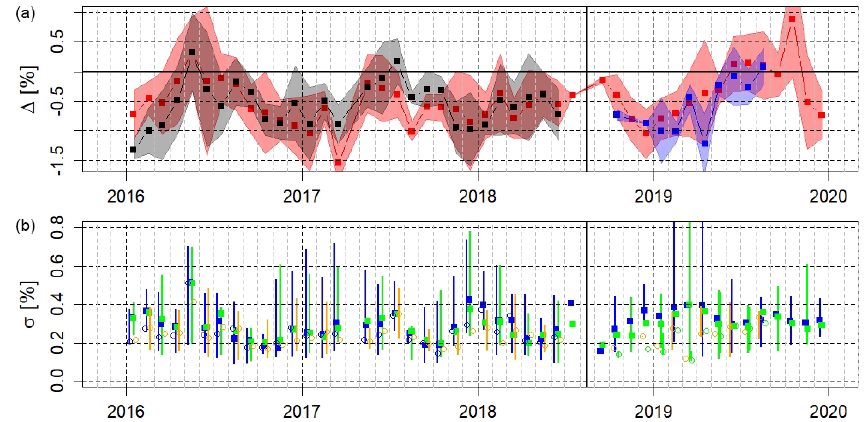
Figure 9. (a) Time series of the monthly median differences (%) between pairs of Dobson measurements at two different sites over the period 2016–2019 with D 062 at Arosa, D 101 at Davos, and D 051 at Arosa before September 2018 and at Davos after: (cid:49) 062–101 (red), (cid:49) 051–101 (black) and (cid:49) 062–051 (blue). Lower panel: time series of monthly medians of σ i : σ 101 (blue), σ 062 (green) and σ 051 (orange). The shading and the error bars indicate the inter-percentile range IPR 97 . 5th–2 . 5th